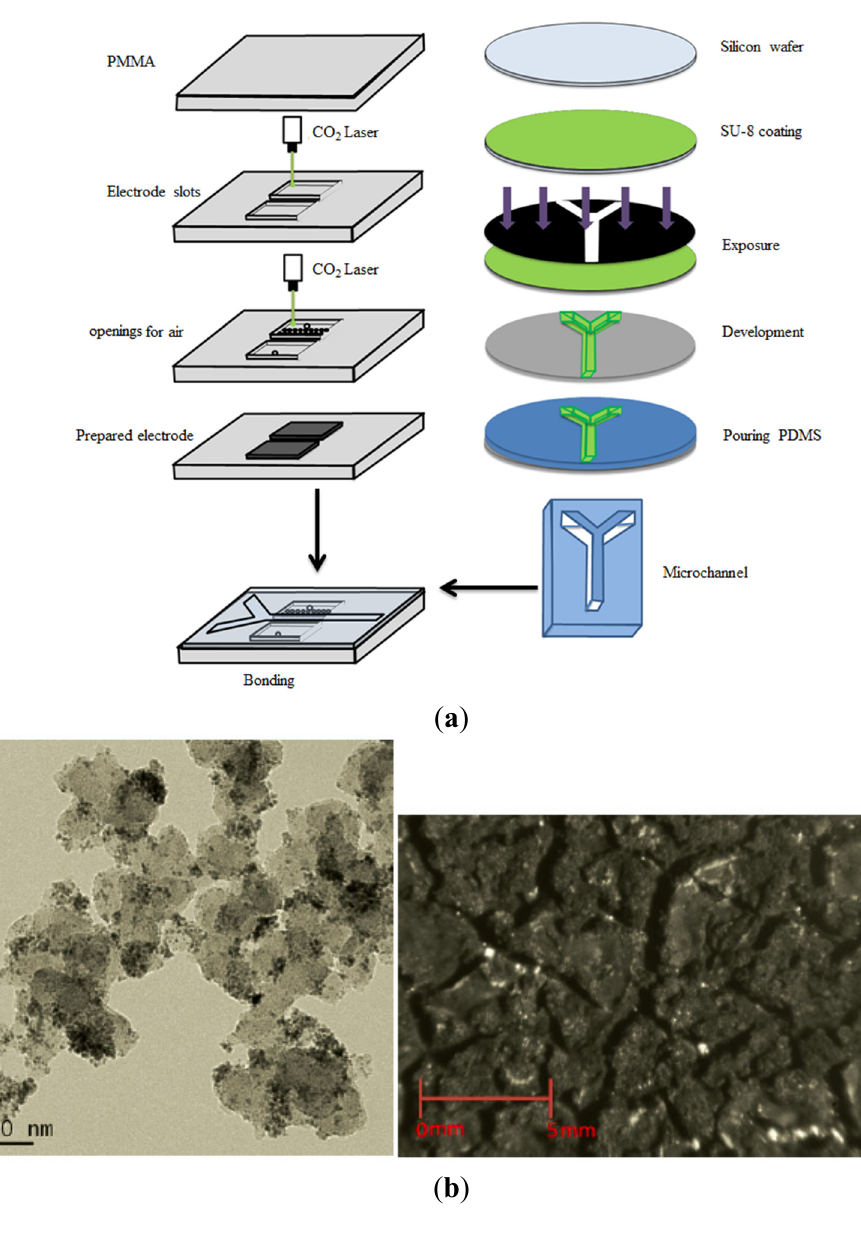
Figure 2. ( a ) Fabrication process of microfluidic fuel cell; ( b ) the TEM image and picture of the self-made